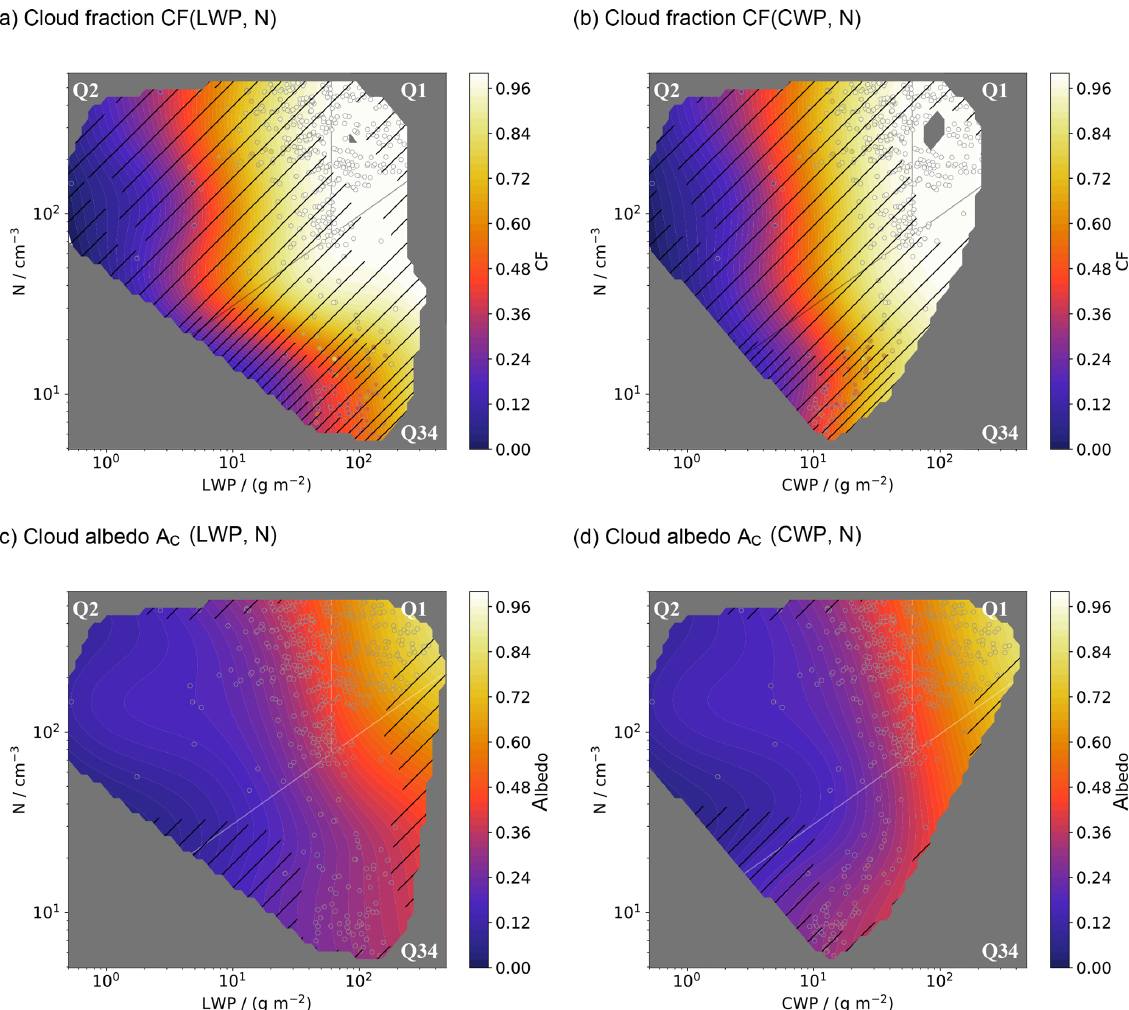
Figure 6. Same as Fig. 5 but showing (a, b) cloud fraction and (c, d) cloud albedo as a function of (a, c) total liquid water path, LWP, and cloud droplet number concentration, N , and (b, d) cloud water path, CWP, and N . The standard deviation, σ , of the emulated variable over the ensemble (Eq. 4) is indicated by hatching, with σ < 0 . 01, 0 . 01 < σ < 0 . 05, and 0 . 05 < σ < 0 . 5 for nonhatched, single-hatched, and double-hatched regions,